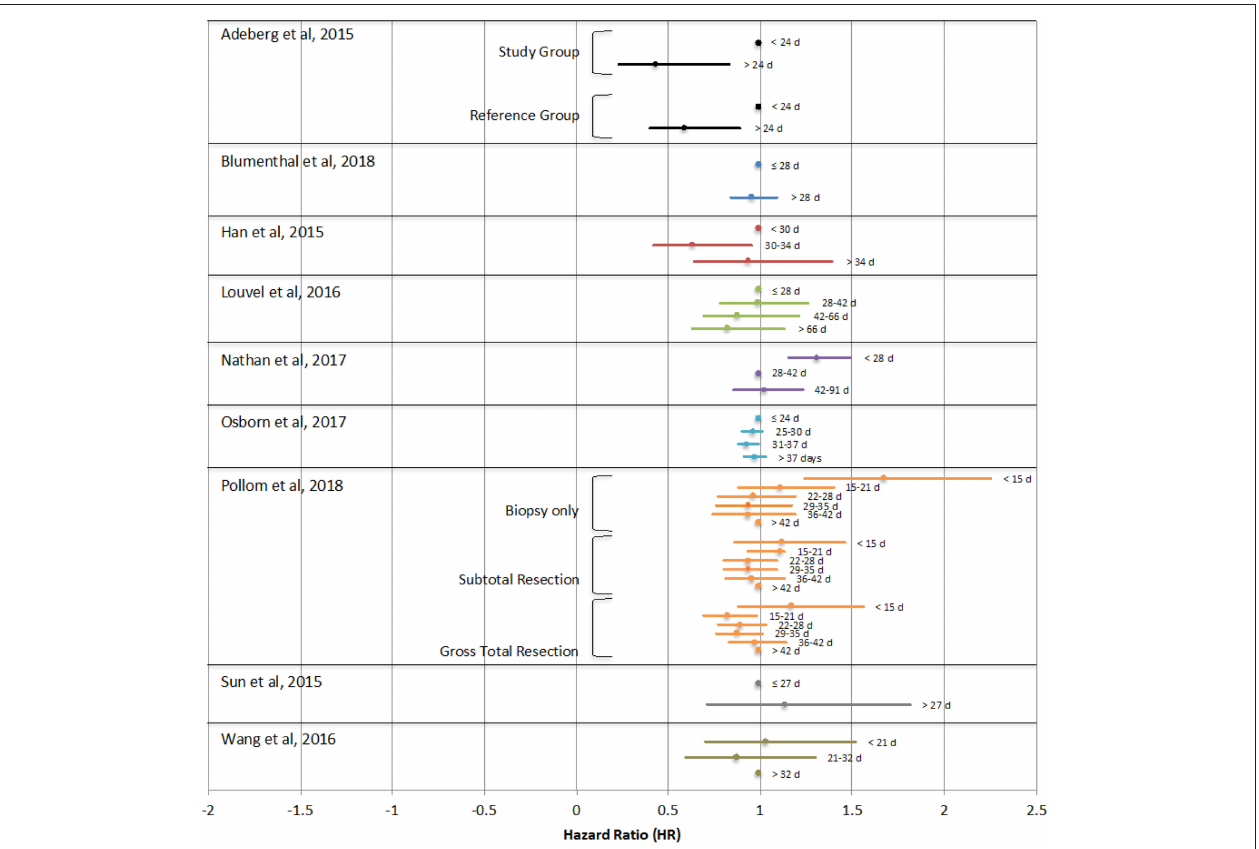
FIGURE 2 | Hazard ratios (HR) of overall survival as they relate to time between surgical resection and initiation of chemoradiotherapy reported in each study. The point depicted with HR = 1 was used as the reference group. Any HR > 1 denotes an increased risk of death. Noel et al. is not indicated in this figure as this study did not report hazard ratios as they relate to treatment